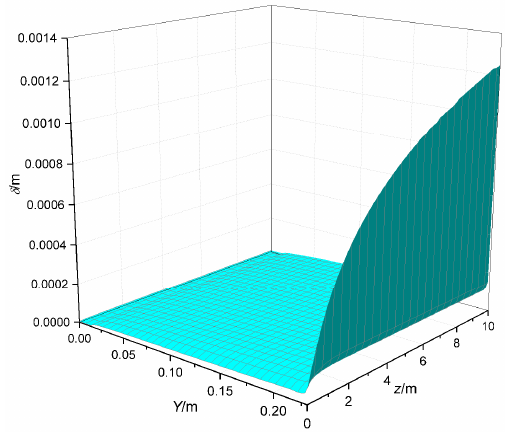
Figure 6. Condensate film thickness on flat tube inner wall.